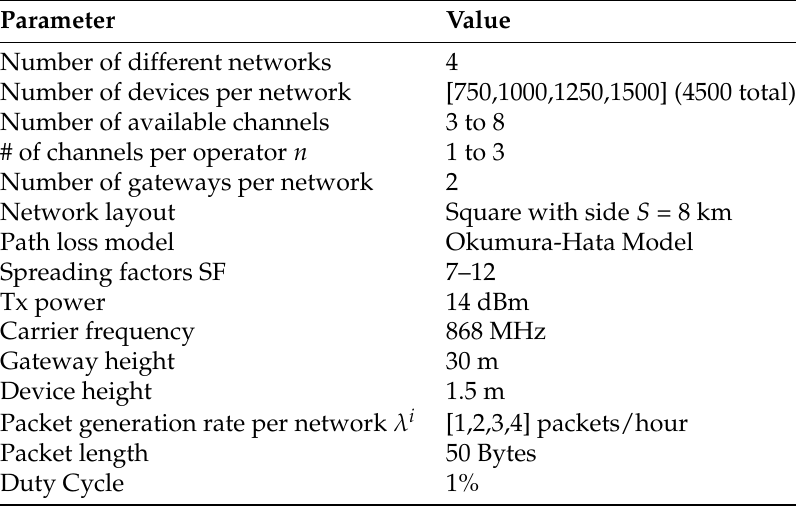
Table 3. Simulation